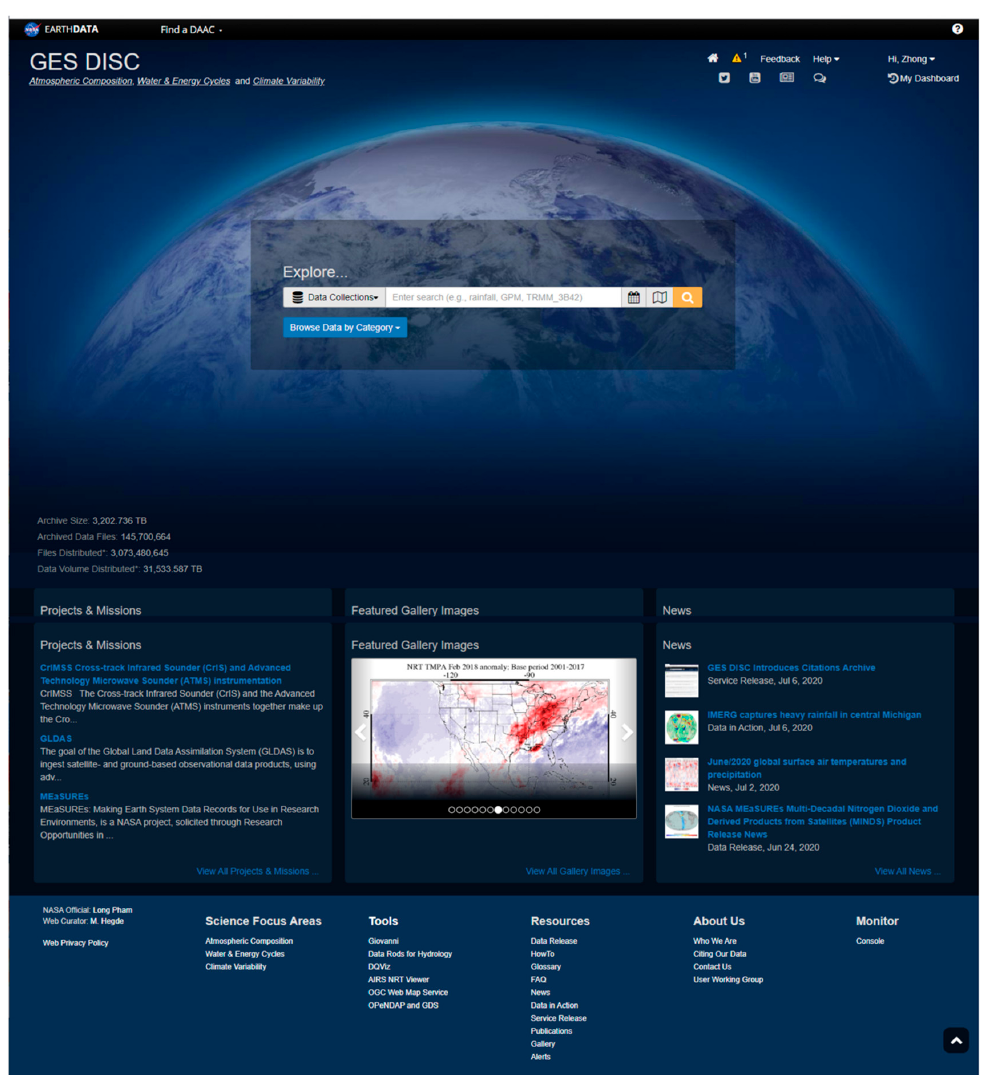
Figure 1. The GES DISC landing page, providing a search box for dataset and information